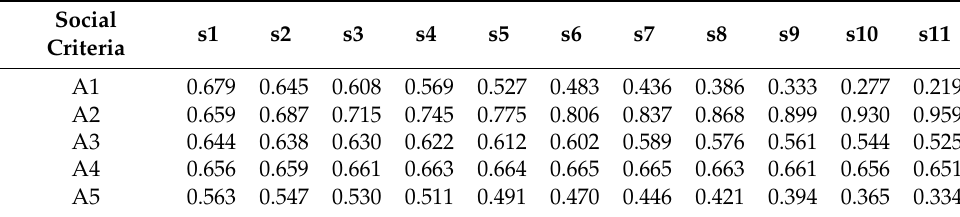
Table 12. New criteria weights for social criteria.